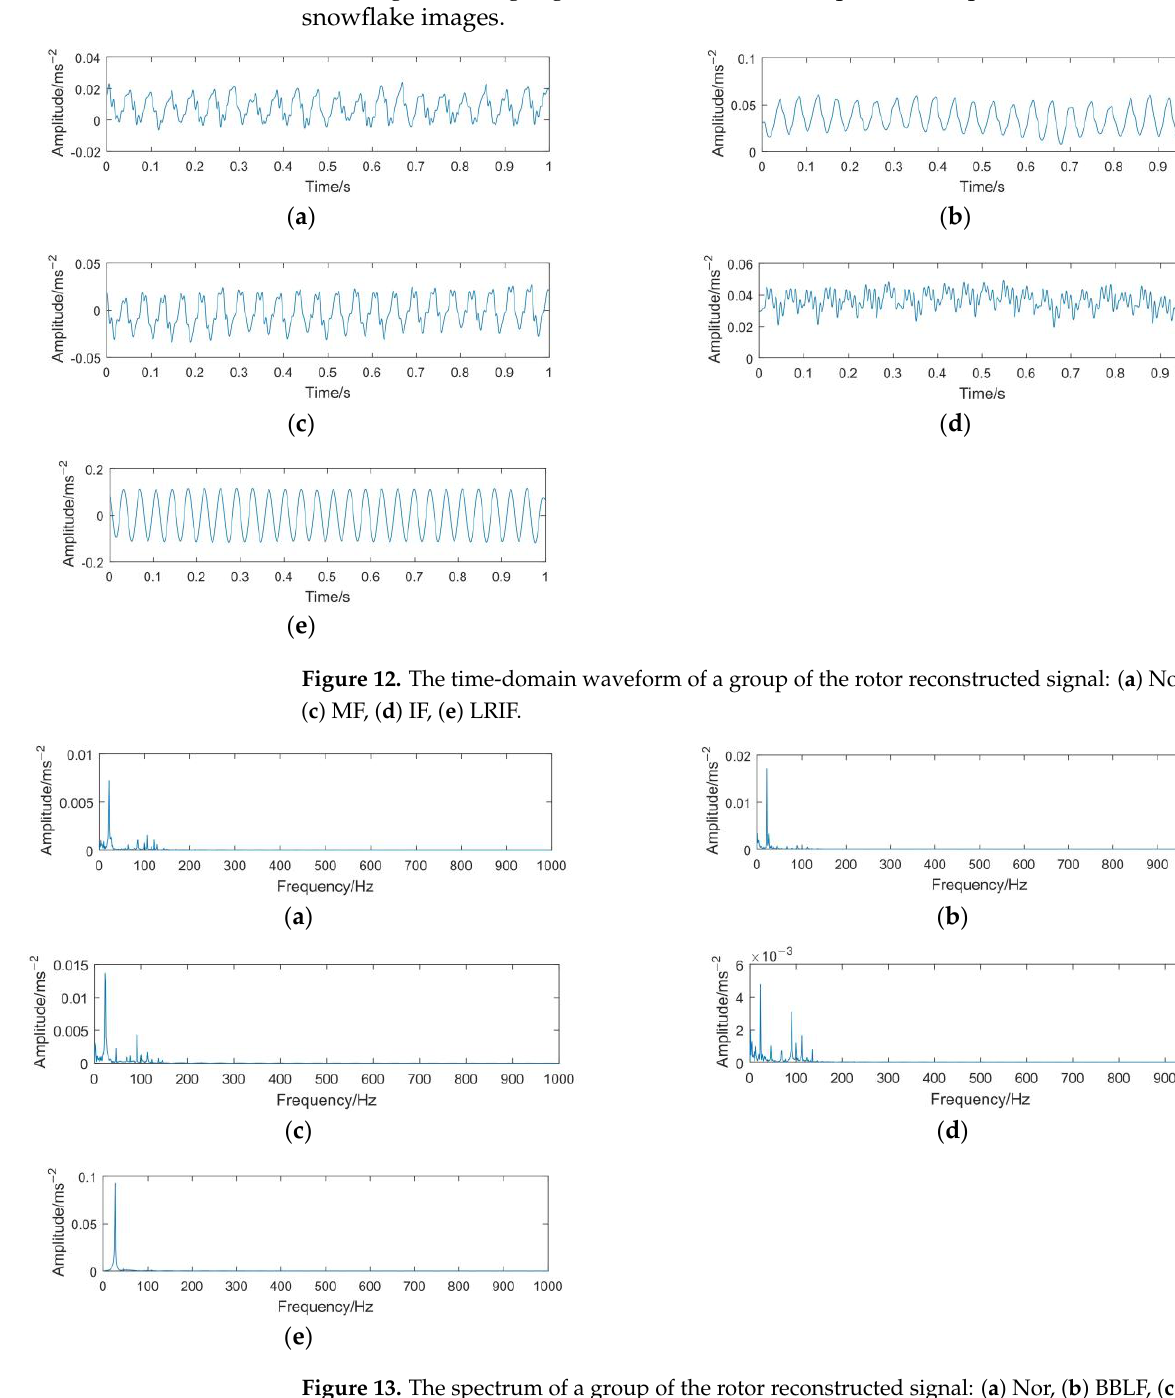
Figure 13. The spectrum of a group of the rotor reconstructed signal: ( a ) Nor, ( b ) BBLF, ( c ) MF, ( d ) IF, ( e ) LRIF.